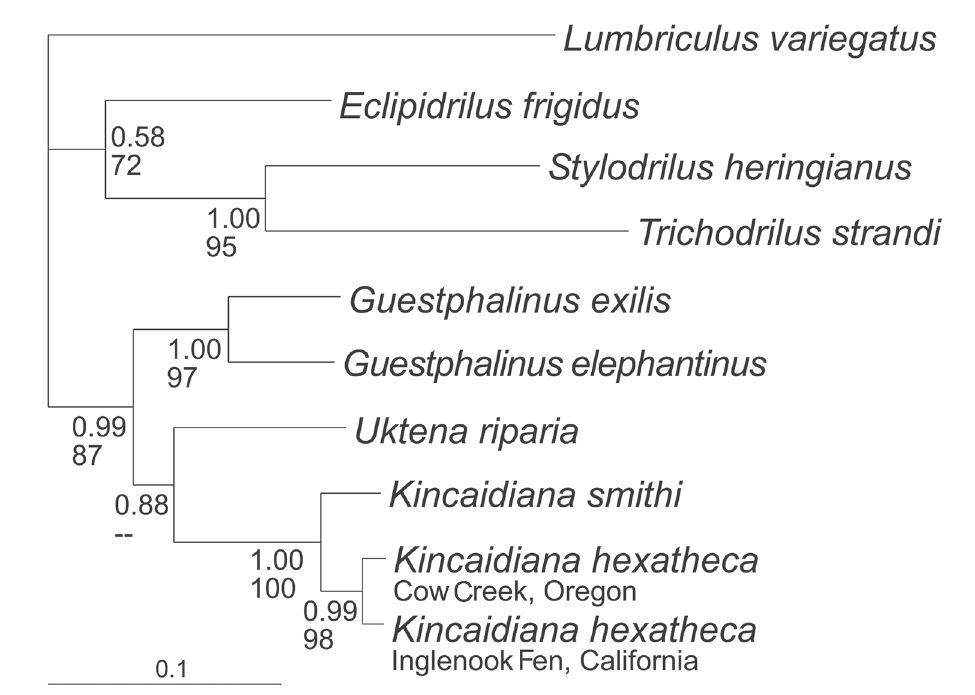
Fig. 13. BA consensus tree derived from the concatenated sequences of COI, 16S rRNA and 28S rRNA genes. Numbers beside internal branches indicate BA posterior probabilities (≥ 0.90) and ML bootstrap values (≥ 70%). The geographical location for two specimens of K. hexatheca Altman, 1936 is given under the taxon